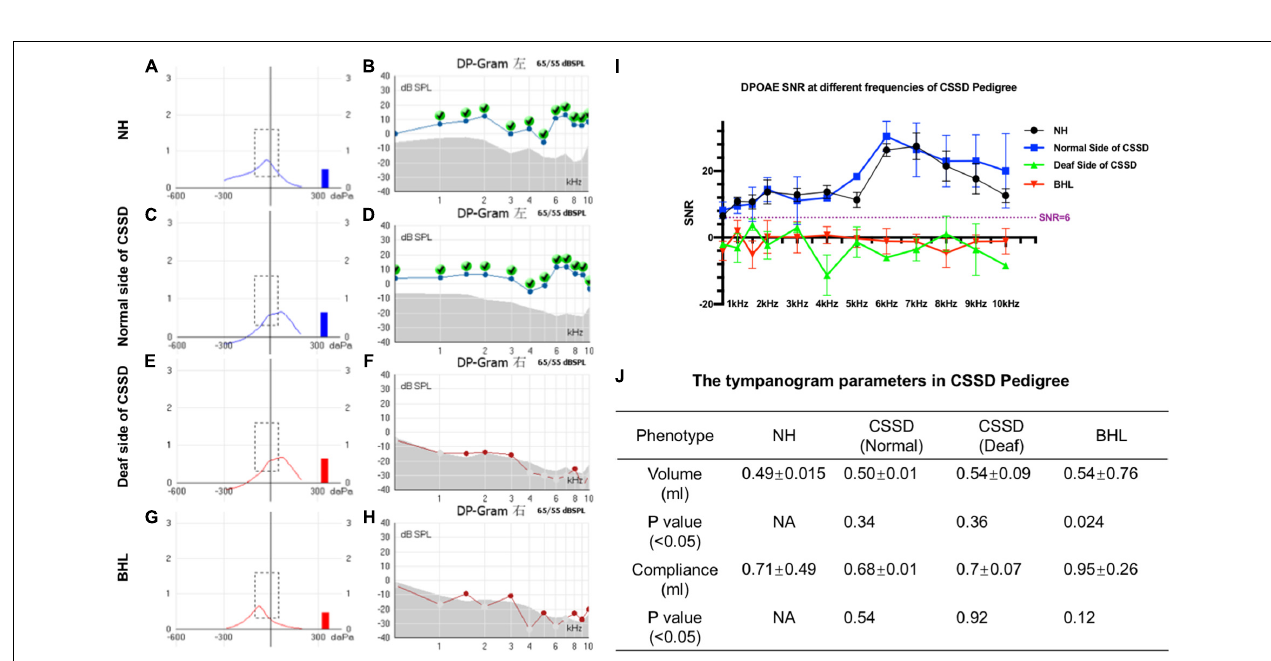
FIGURE 3 | Distortion product otoacoustic emission (DPOAE) and tympanogram results of congenital single-sided deafness (CSSD) pedigree. (A,C,E,G) Tympanograms of each phenotype in the CSSD pedigree. (B,D,F,H) DPOAE results from 500 Hz to 10 kHz of each phenotype in the CSSD pedigree at P1. (I) Signal-to-noise ratio (SNR) of DPOAE at each frequency of different phenotypes in the pedigree. (J) Volume and compliance of the middle ear of each phenotype in the pedigree ( P < 0.05 was considered statistical different).